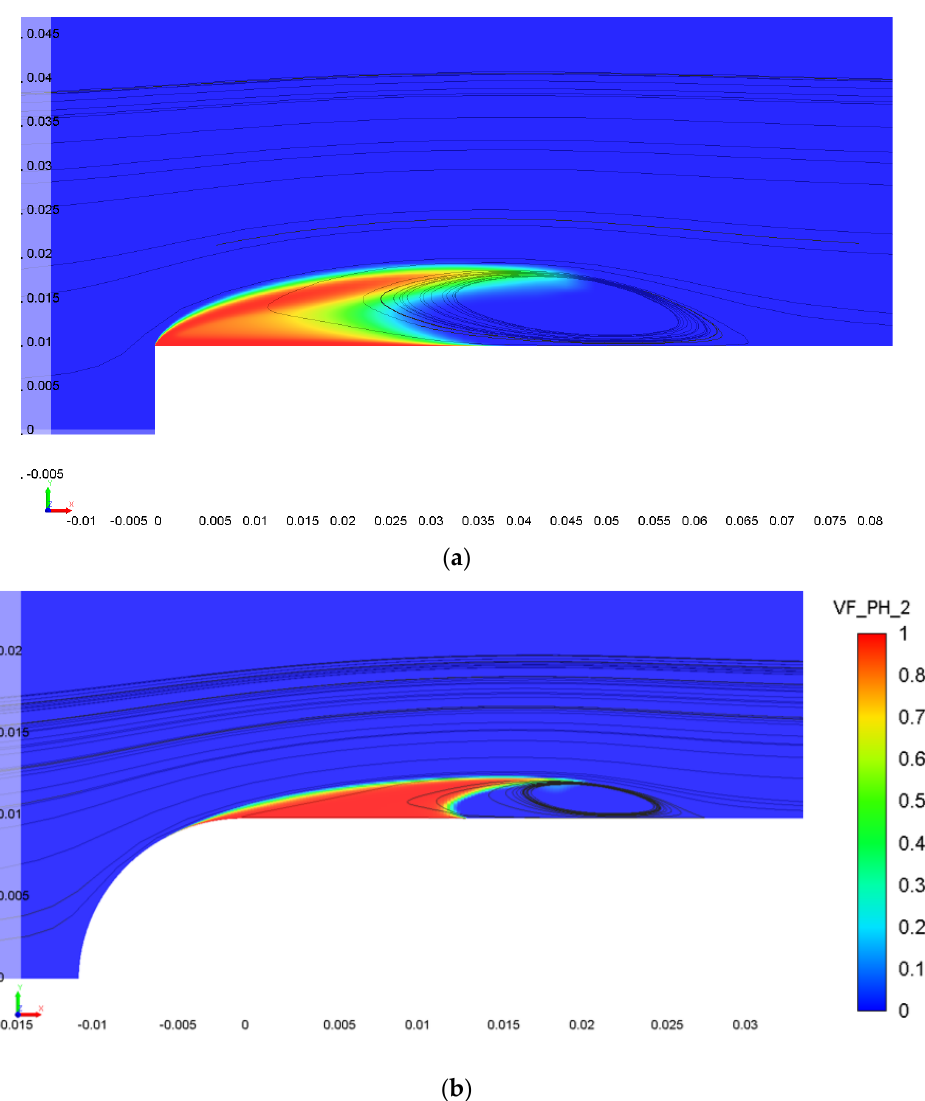
Figure 3. The vapor volume fraction distribution: ( a ) a cylinder with a plane end; ( b ) a cylinder with a semispherical end.